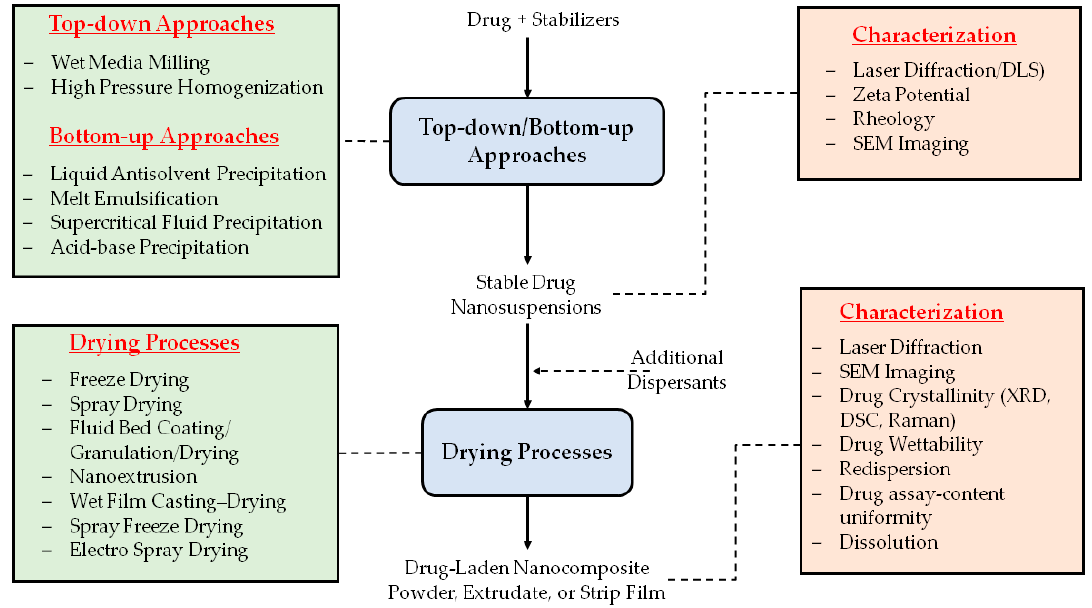
Figure 1. Schematic illustrating the steps involved in the preparation of drug-laden nanocomposites including their characterization. Nanocomposites in the form of powders, cakes, or extrudates are intermediate products that are incorporated into final solid oral dosage forms such as tablets, capsules, and sachets via standard pharmaceutical unit operations upon use of additional excipients. Polymeric strip films prepared by wet film casting–drying are the final product.